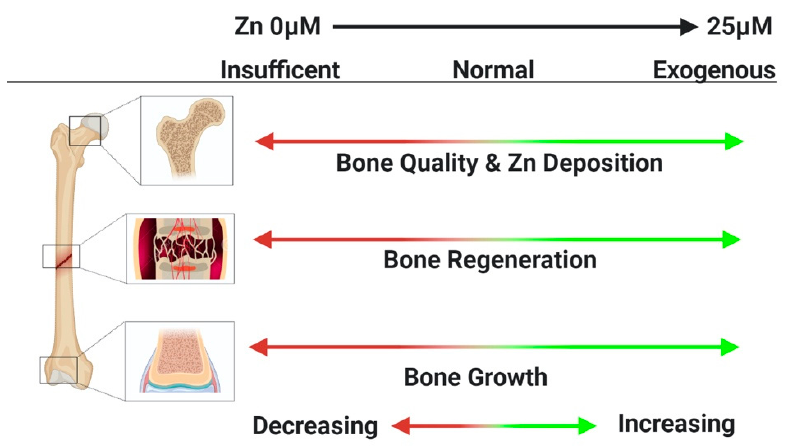
Figure 1. Roles of Zinc in the Skeleton.